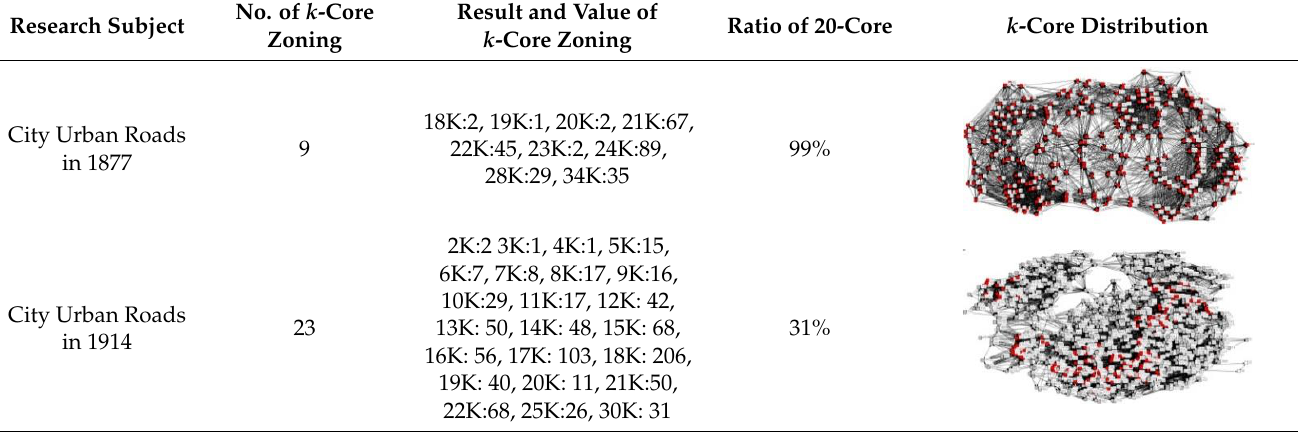
Table 4. Road k -core in the Changsha Historic Urban Area in Various Periods.